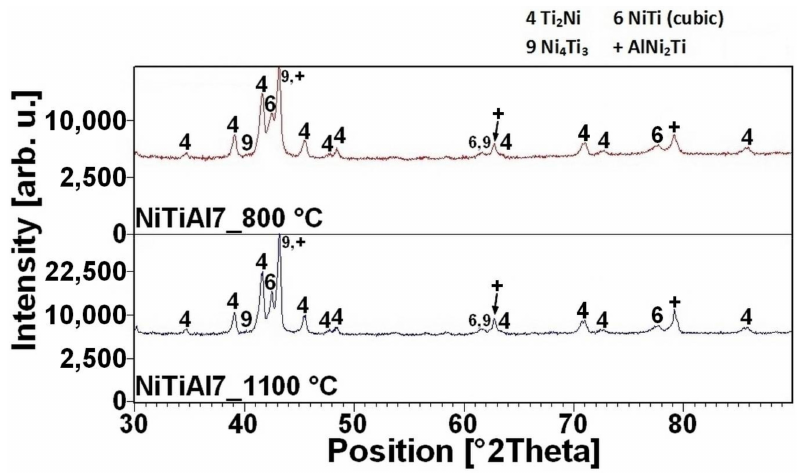
Figure 9. XRD patterns of the NiTiAl7 sample sintered at 800 and 1100 ◦ C.